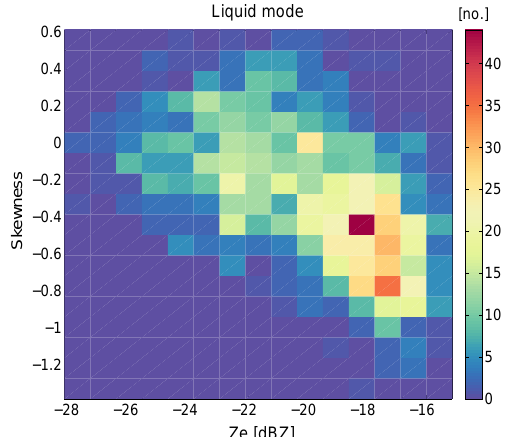
Figure 9. A joint PDF of frequency of occurrence (number of pix- els) of skewness and reflectivity of supercooled liquid mode encom- passed by the two black fall streaks in Fig.